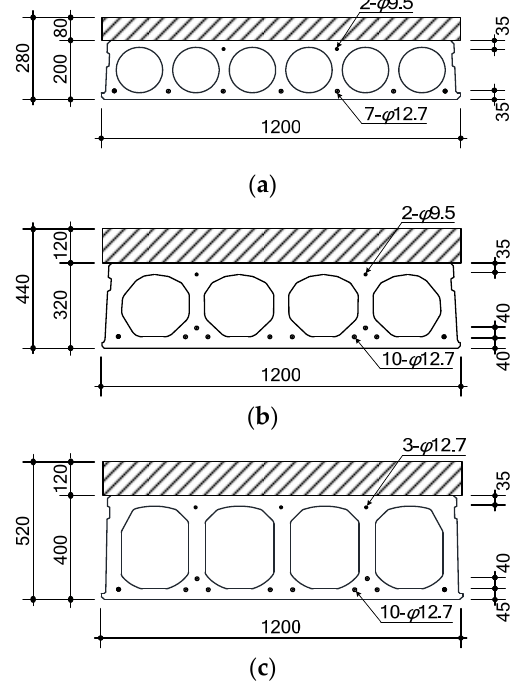
Figure 4. Details of cross-section (unit: mm): ( a ) CF200 and CN200; ( b ) CF320 and CC320 and CN320; ( c ) CF400 and CN400.